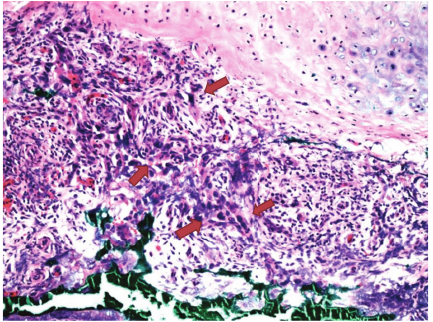
Figure 4: 100x magnification of area directly below the perforated cartilage. Large pleomorphic cells are present